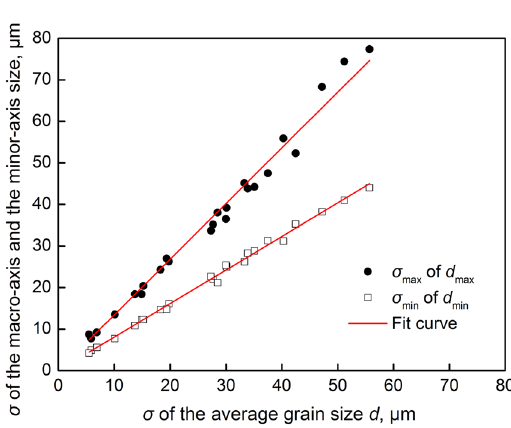
Figure 11. The relationships of the standard deviations of the macro-axis and minor-axis size with that of the average size.